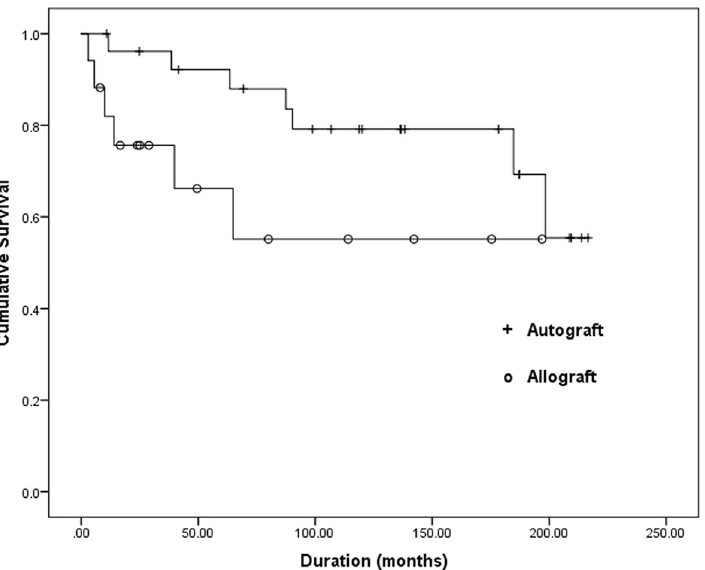
Figure 3. Kaplan–Meier survival curve of the bone graft in the subgroup of patients who did not receive chemotherapy. There was no statistically significant difference between the nonvascularized autograft and allograft groups ( p = 0.06).